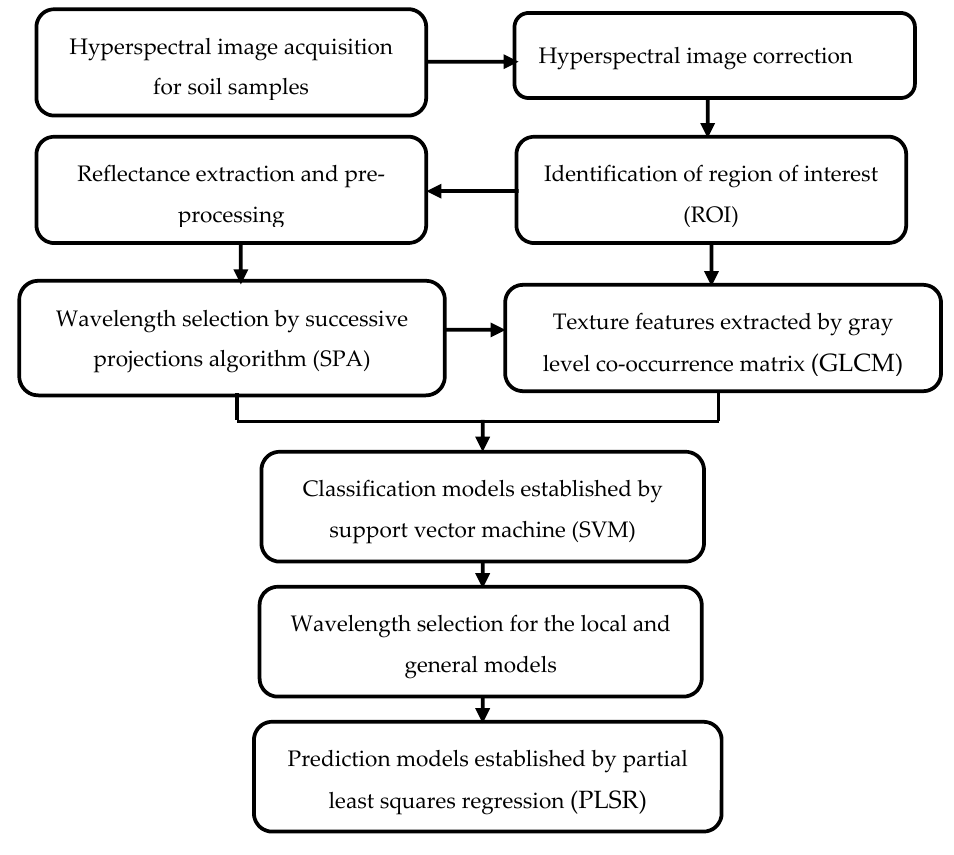
Figure 2. Main steps of this work.